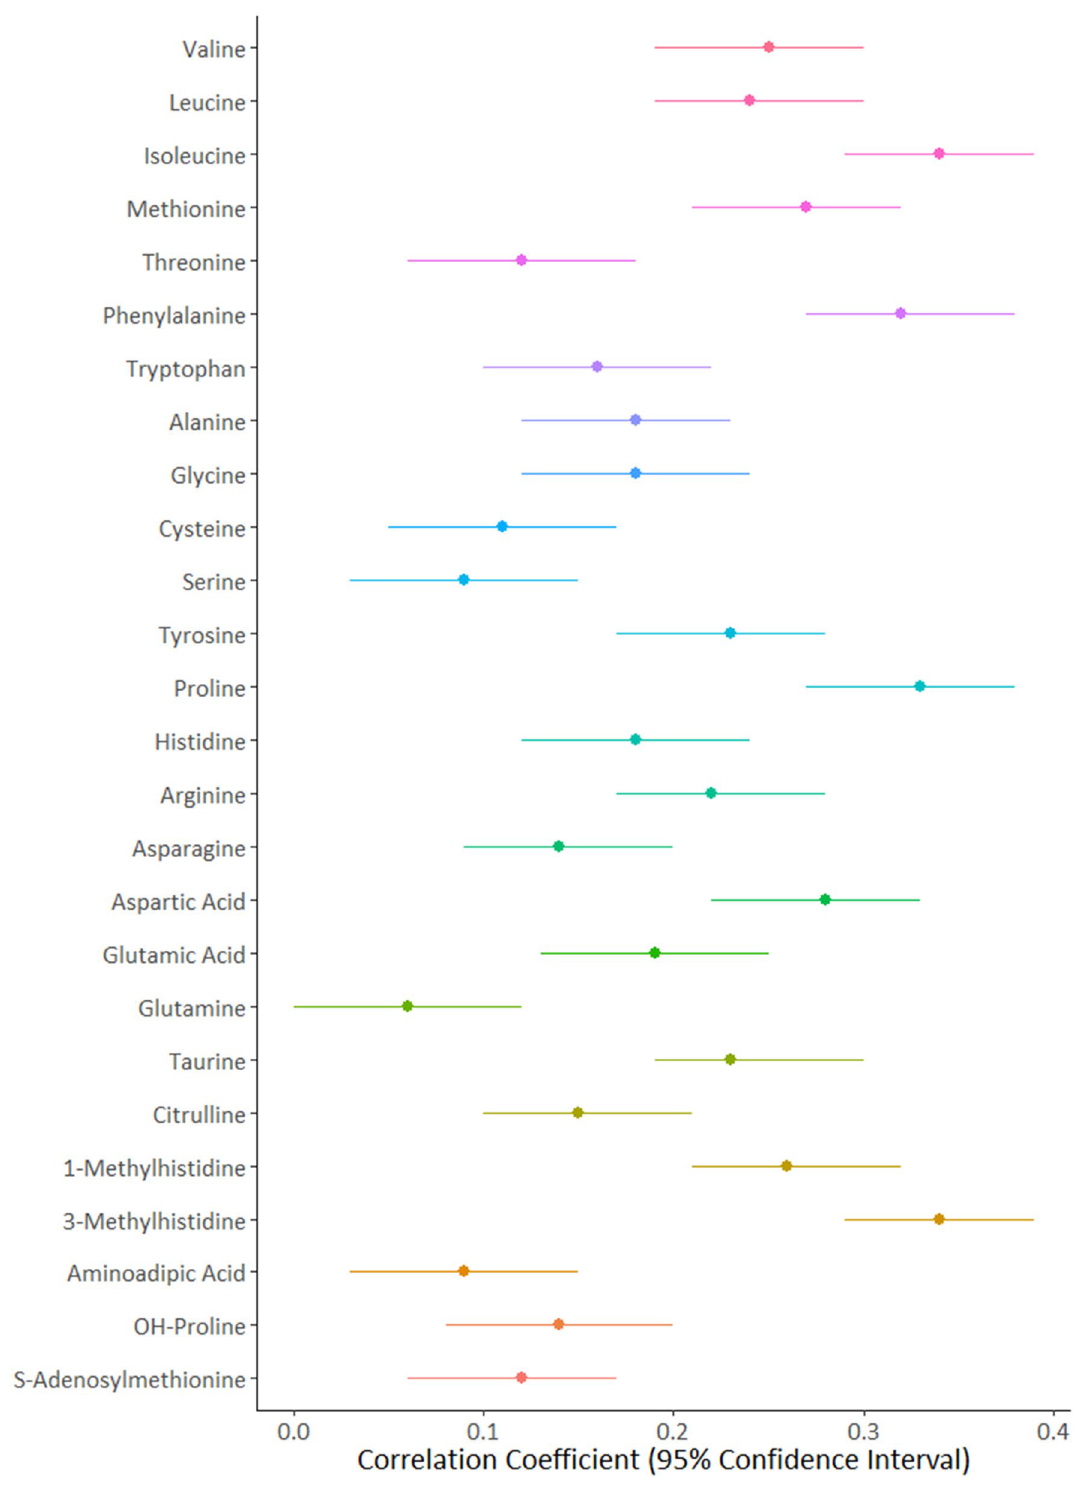
Figure 1. Forest plot of Pearson’s correlations within parent–child